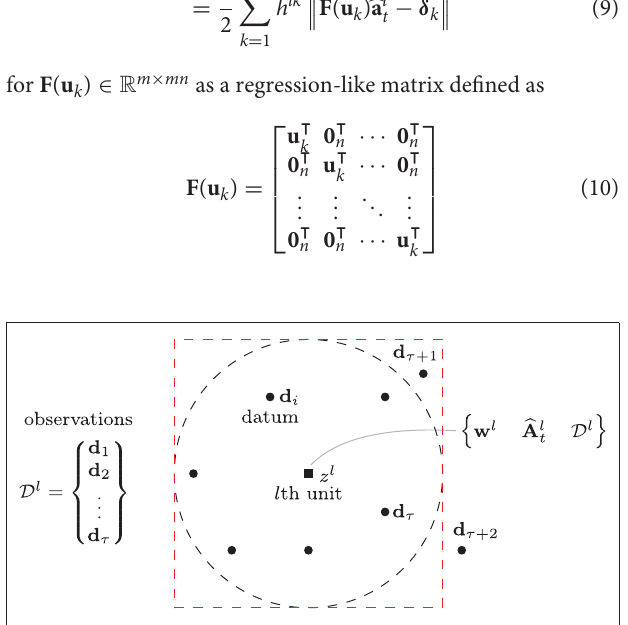
FIGURE 2 | Representation of the l th computing unit and the neighboring data used to approximate the local sensorimotor model. The black and red dashed depict the Gaussian and its square